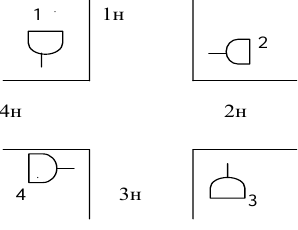
Fig 2. Traffic lights